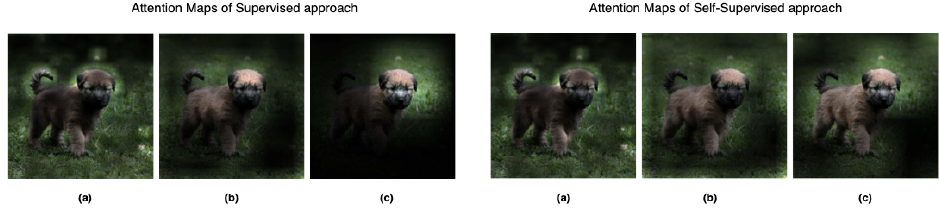
Figure 18. Attention maps generated by a trained AlexNet. Left set of images represent a supervised approach and right set of images represent a self-supervised approach. The images represent the attention maps applied on features from different convolutional layers, ( a ) Conv1 27 × 27, ( b ) Conv3 13 × 13, and ( c ) Conv5 6 × 6.